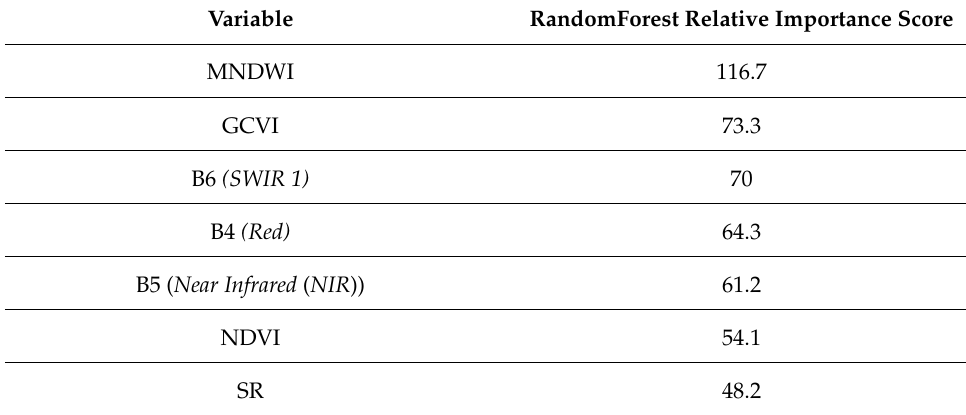
Table 1. Relative importance scores for each variable used in the MSTRF mangrove habitat model for the combination of a 4-year optimal